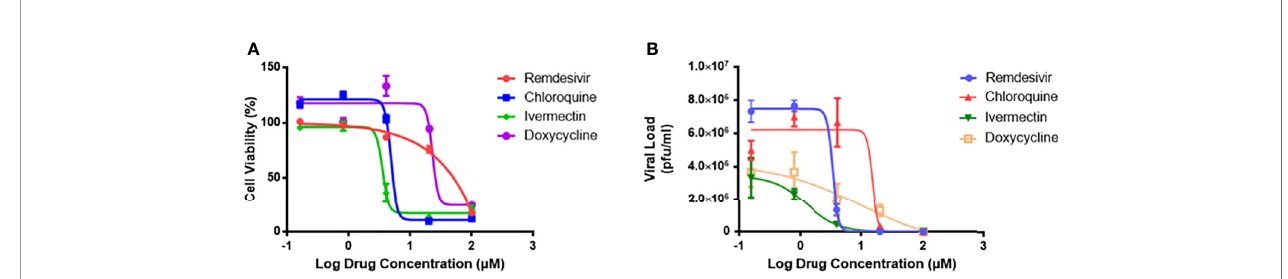
FIGURE 1 | The drug cytotoxicity pro fi les of RAW264.7 macrophages, and dose-response curves of MHV-infected macrophages. (A) Cytotoxicity pro fi les of the four individual drugs on RAW264.7 cells as measured by MTS assay after 48 hours exposure. Percentage of cell viability was normalized to untreated cells and blank control. Experiments were performed in quadruplicates. (B) Viral inhibitory activities of the four drugs against MHV infection of RAW264.7 macrophages. Live coronavirus titers (pfu/ml) were quanti fi ed by plaque assays performed in triplicates. The dose-response curves were fi tted using the non-linear regression method, and IC50 values were calculated using the Prism 7 software. Error bars represent standard error of the mean (SEM).